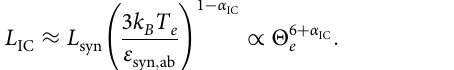
where M is the mass of the supermassive black hole (SMBH), ¼ 2 GM = c 2 is the Schwarzschild radius. The R ¼ R = R , and R S S thermal electrons up-scatter the synchrotron photons, and the resulting spectrum can be approximated by a power-law form, where and over other cooling processes, which is satis fi ed for _ m ≳ 2 ´ 10 (cid:3) 3 as seen in Table 2. In this case, the luminosity of the Comptonized photons is